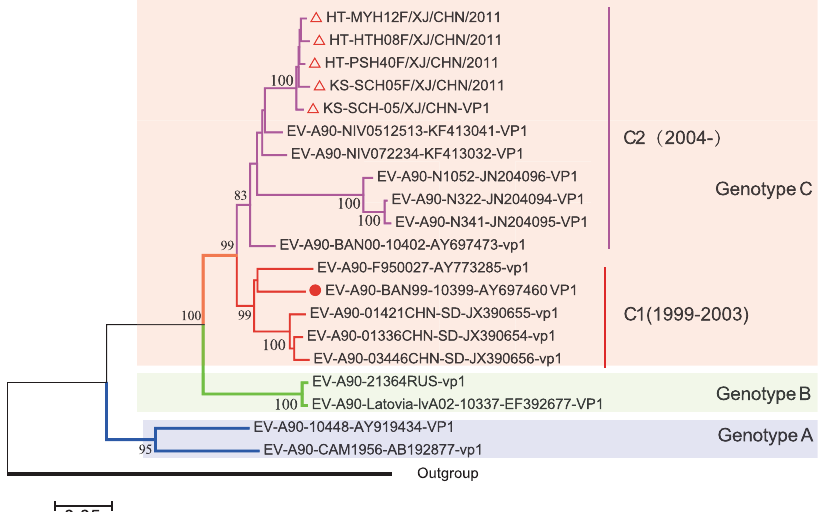
Figure 1. Phylogenetic tree of global EV-A90 based on entire VP1 sequence. Isolates from Xinjiang were marked with and the prototype of EV-A90 (BAN00-10399) was marked with . The phylogenetic tree was reconstructed using neighbor-joining method with the substitution model of maximum composite likelihood model.